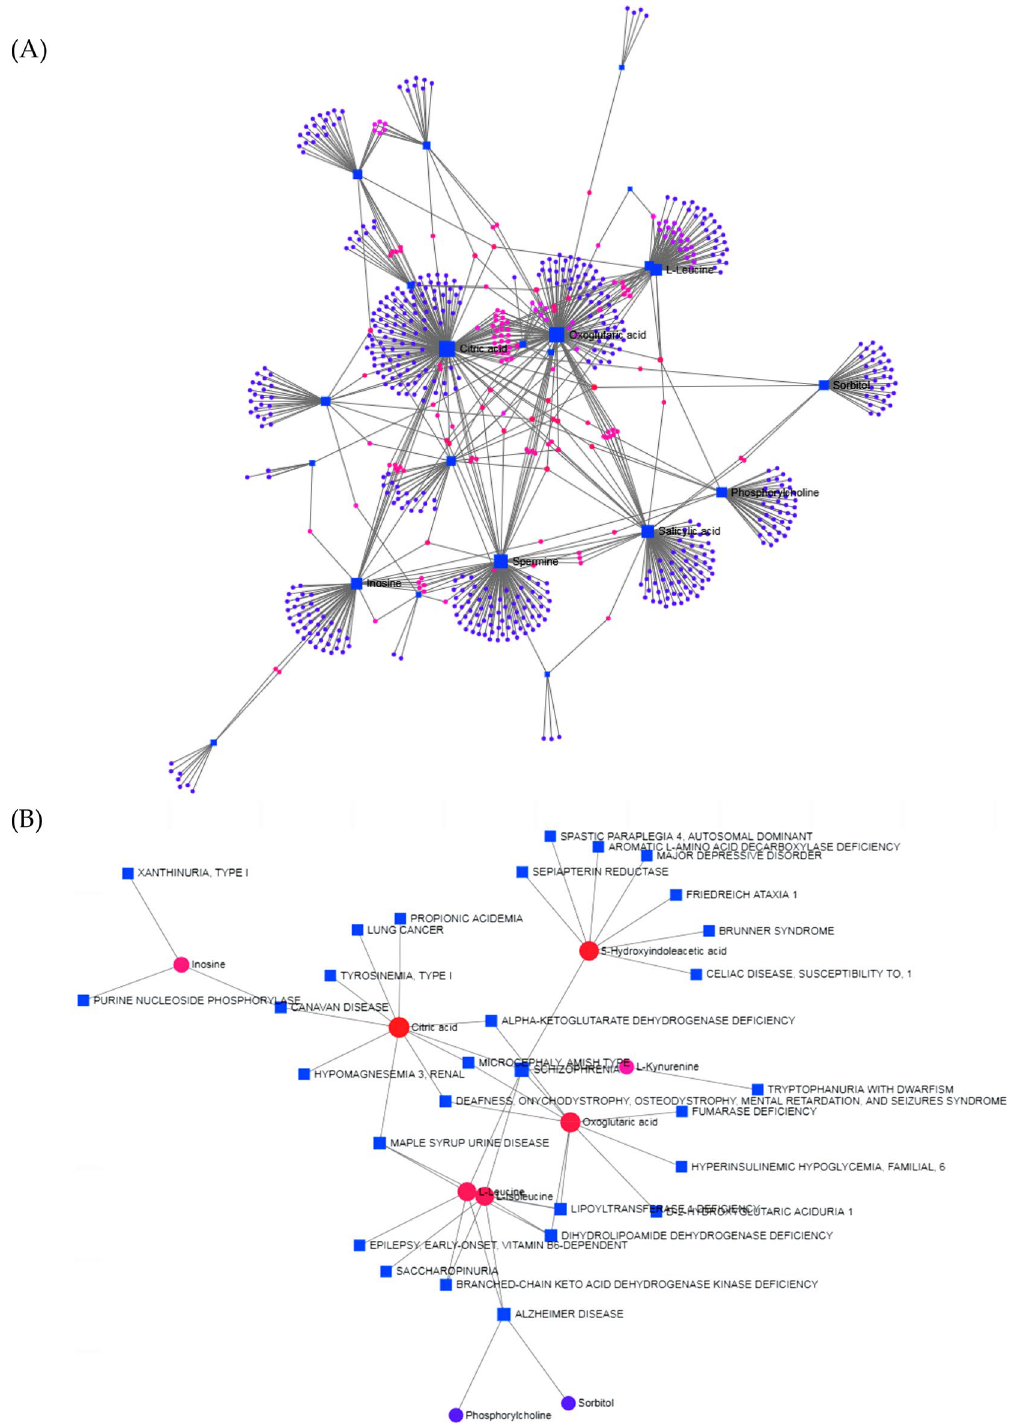
Figure 5. Analysis of interaction between different metabolites and diseases, genes. ( A ) Gene–metabolite interaction networks. ( B ) Metabolite–disease